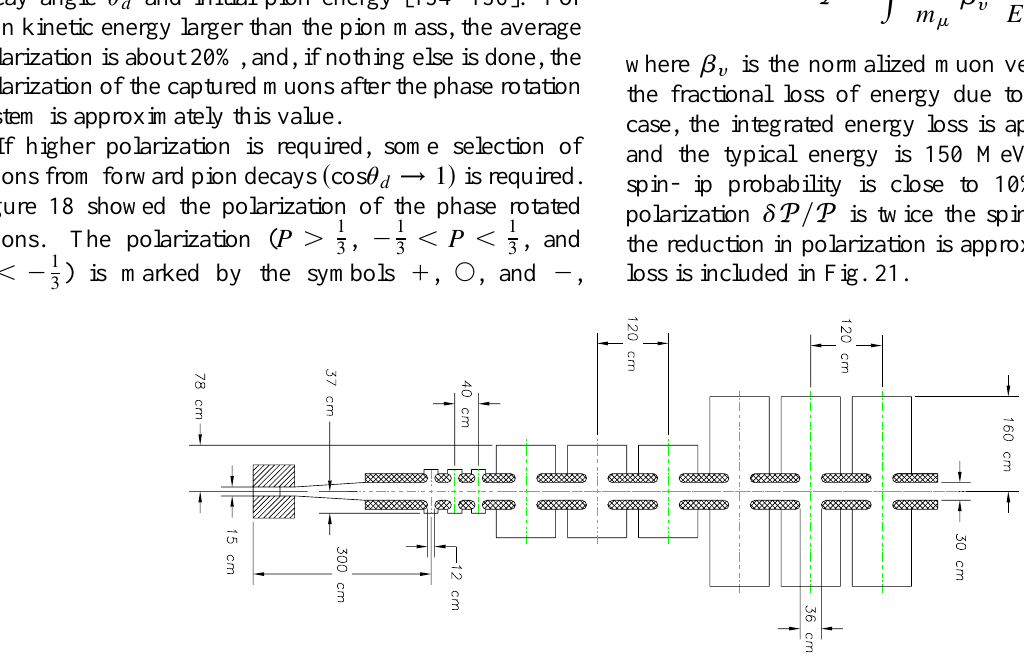
FIG. 20. (Color) Schematic of capture and phase rotation using rf cavities with superconducting solenoids (hatched areas) inside the irises. Three groups of three cavities operating at 90, 50, and 30 MHz are shown from left to right, respectively.